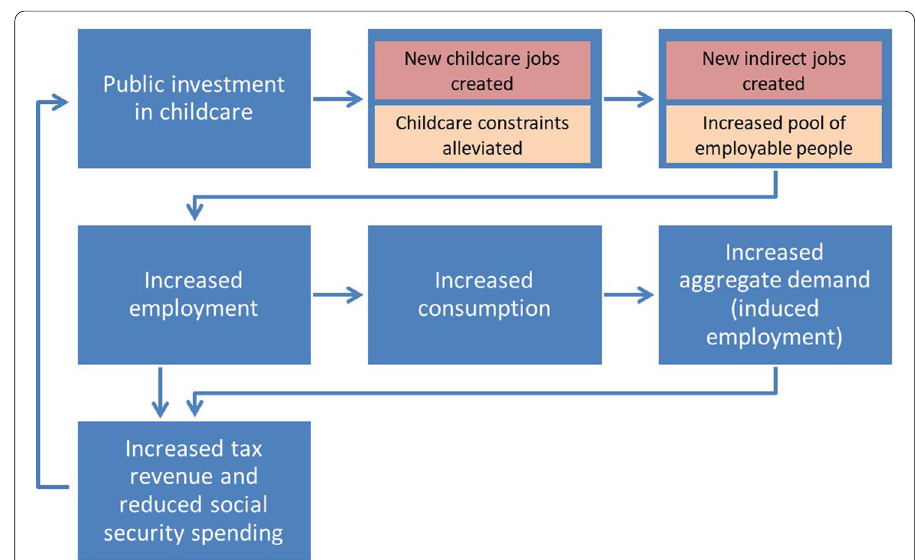
Fig. 1 Employment and fiscal effects of investing in universal ECEC